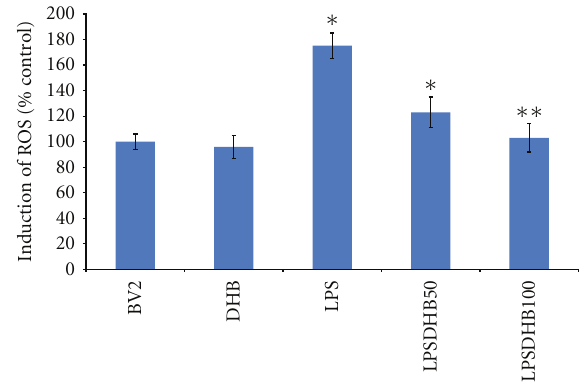
Figure 2: BV2 microglial cells were pretreated with DHB for 1h followed by co-treatment with LPS (100 ng/mL) for 16h. ROS levels were measured using the DCFDA method. ∗ P < 0 . 05 compared with the control group, ∗∗ P < 0 . 05 compared with the LPS-treated